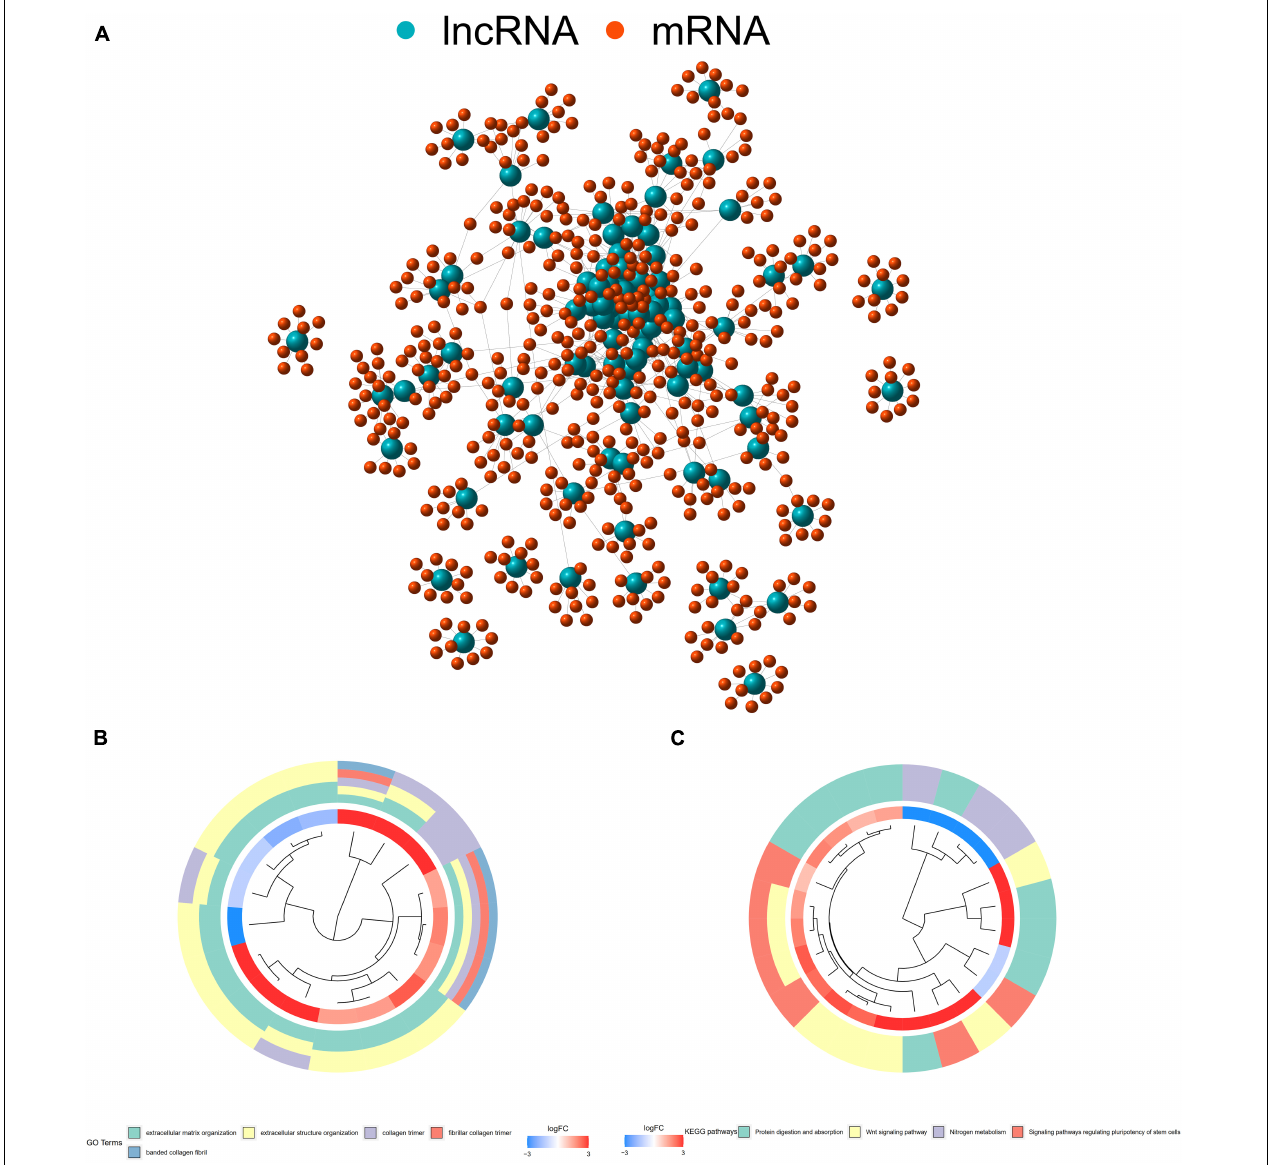
FIGURE 2 | (A) The expression correlation between DEirlncRNAs and mRNAs were shown as an Long non-coding ribonucleic acids (lncRNAs)–mRNA co-expression network, wherein lncRNAs and associated mRNAs were linked together with lines. (B) DEirlncRNAs were primarily related to the biological functions of extracellular matrix organization, extracellular structure organization, collagen trimers, fibrillar collagen trimers, and banded collagen fibrils. (C) These DEirlncRNAs also participated in the pathways of protein digestion and absorption, WNT signaling, nitrogen metabolism, and signaling pathways regulating the pluripotency of stem